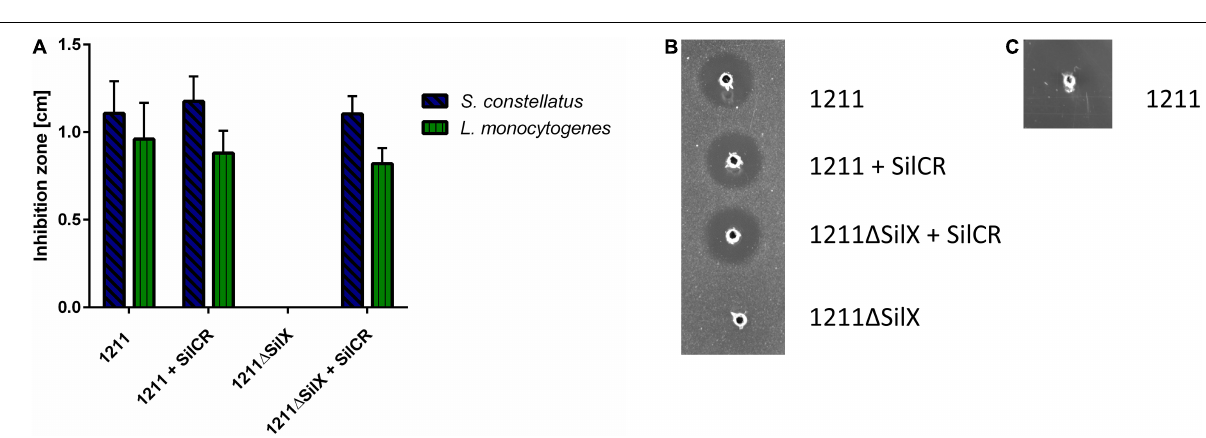
FIGURE 3 | S. anginosus BSU 1211 (cid:49) SilX has no antimicrobial activity against S. constellatus and L. monocytogenes . A SilX deletion mutant of S. anginosus was tested in a RDA against S. constellatus and L. monocytogenes either alone or supplemented with 10 µ g x ml - 1 SilCR. (A) Depicted is the mean of inhibition zone diameter ± standard deviation of at least 5 independent experiments. No significant differences were found with a Mann-Whitney-U test. (B) Depicted is a RDA of S. anginosus BSU 1211 and S. anginosus (cid:49) SilX with S. constellatus as target strain under supplementation with 10 µ g x ml - 1 SilCR as indicated. (C) Depicted is a RDA of S. anginosus BSU1211 (cid:49) SilX as a target strain against S. anginosus